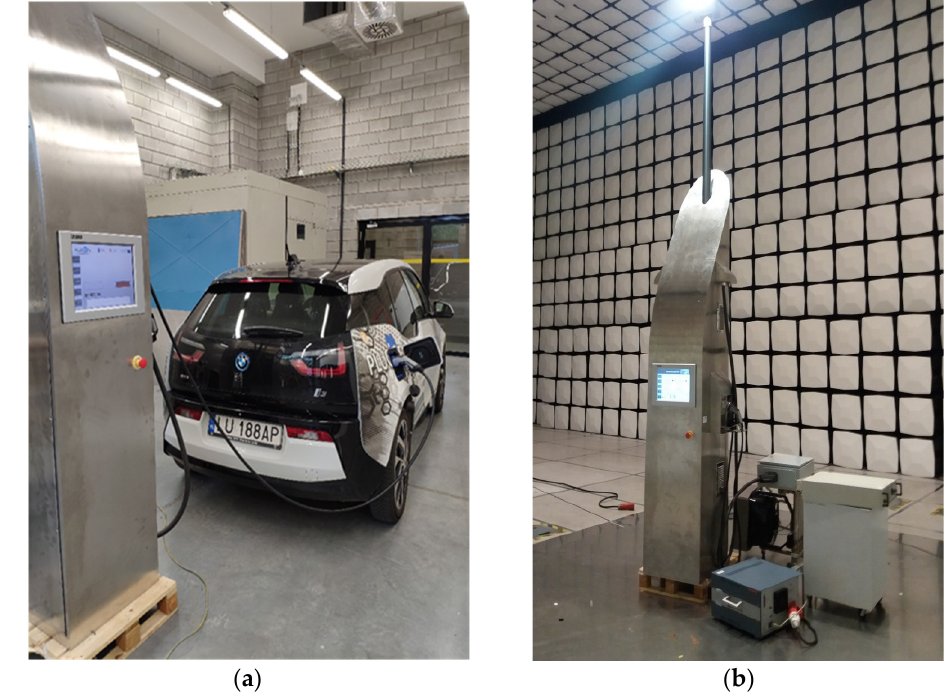
Figure 2. The PLUGinEV charging station. ( a ) BMW i3 connected to the tested charging station at the laboratory of the Lublin University of Technology; ( b ) the PLUGinEV charging station during electromagnetic emission measurements in the screen chamber at the Wroc ł aw University of Tech ‐